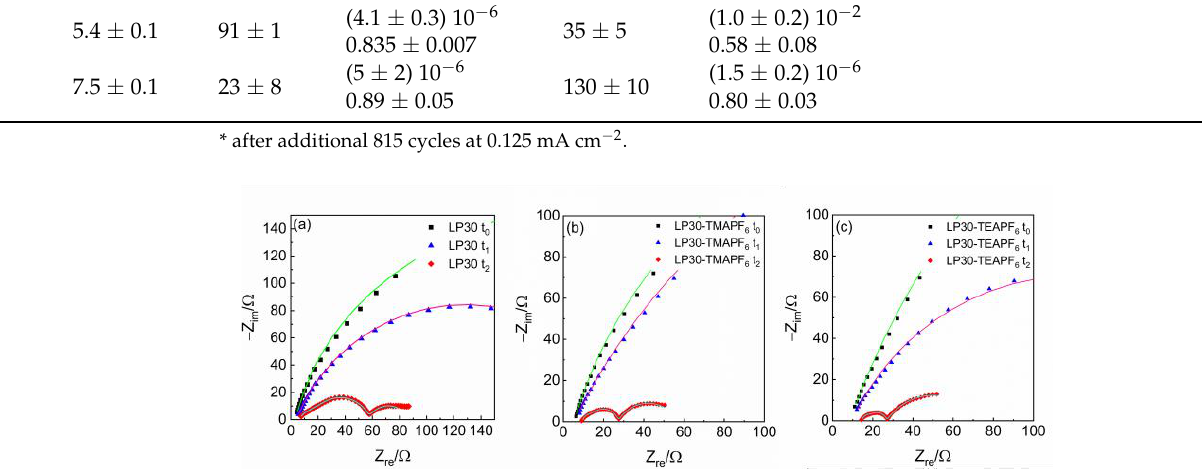
Table A3. Fitting parameters of the impedance spectra over deposition/stripping tests of Li||Li cells with PC-based solutions. t 0 = before test, t 1 = after 10 cycles at 0.125 mA cm − 2 , t 2 = after additional 10 cycles at 0.250 mA cm − 2 , 100 cycles at 0.500 mA cm − 2 and 10 cycles at 0.125 mA cm − 2 . The fitting data with the highest relative errors are reported in grey.